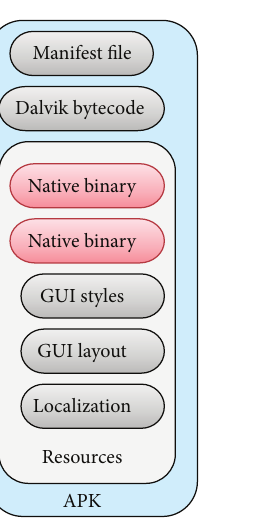
Figure 3: The android installation file containing malicious compo- nents.